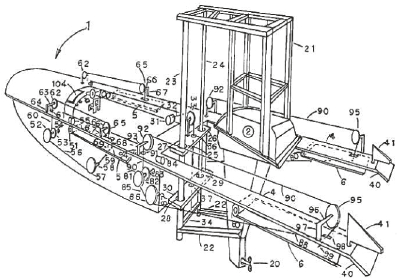
Figure 3: Patented on smart flying boat.